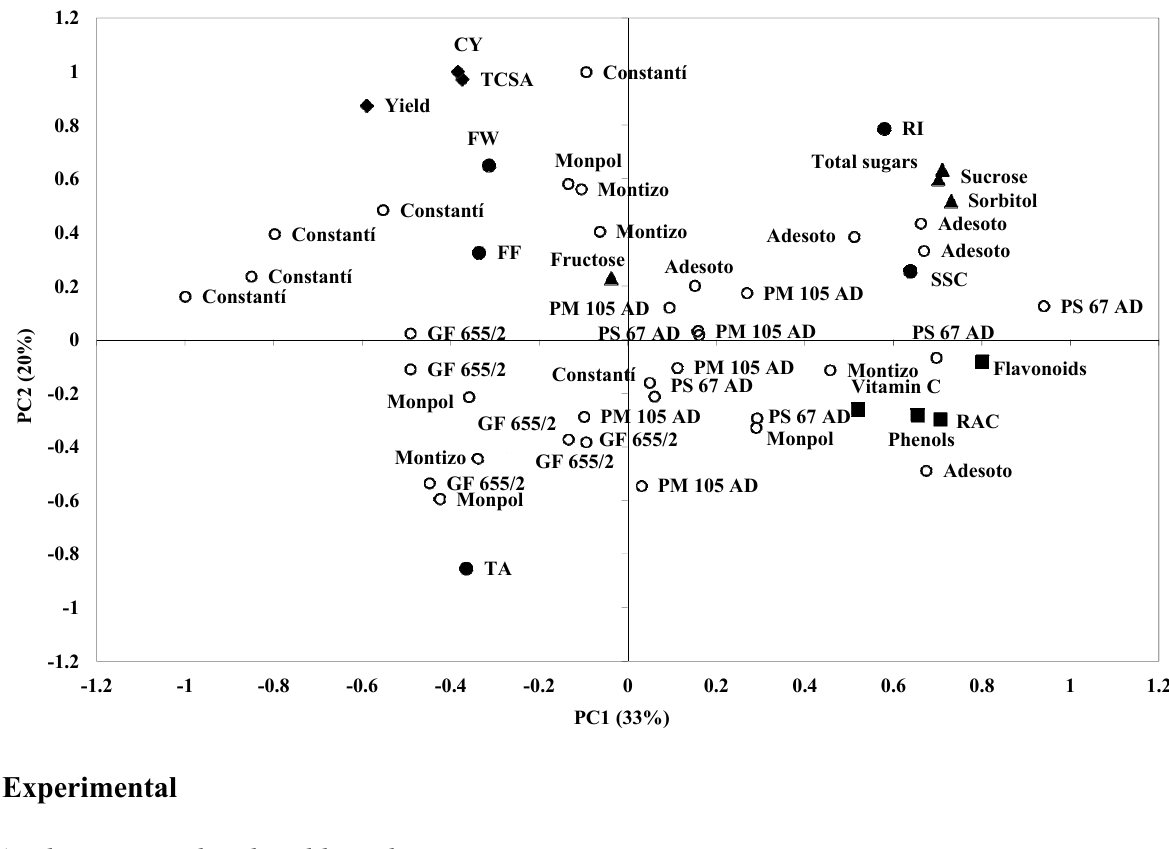
Figure 1. Principal components analysis for the agronomic, basic fruit quality and phytochemical traits evaluated on different plum rootstocks budded with “Catherine” peach cultivar. Analysis was performed using mean data of the three years of study (2009–2011). Symbols: ( ♦ ) agronomical traits; ( ● ) basic quality fruit traits; ( ▲ ) sugars; ( ■ ) antioxidants compounds; and (  ) studied